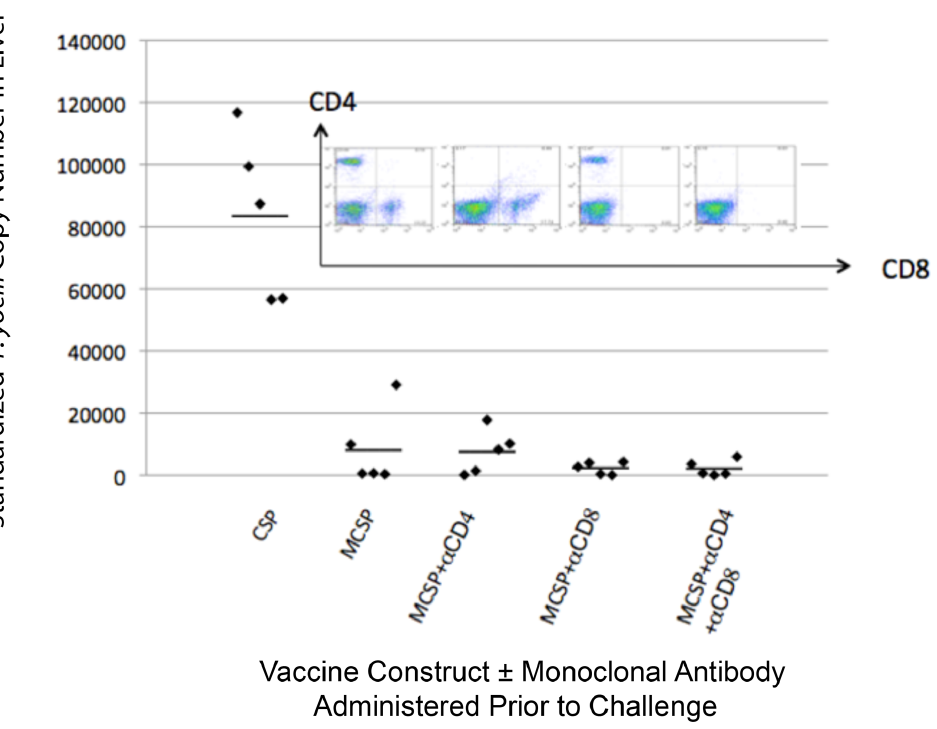
Figure 6. Effect of T cell depletion just prior to challenge on protection provided by Vaxfectin plus MCSP immunization. Two weeks after the final immunization, recipients of MCSP DNA were depleted of CD4, CD8 or both T cell subsets. The efficacy of the T-cell depletions is indicated by the flow cytometry analysis shown in the inset. The mice were then challenged with 2 6 10 3 P. yoelii sporozoites. The standardized P. yoelii rRNA copy number in the livers of individual mice (5/group) and the mean for each group are shown. Not shown in the figure is that all immunized mice received Vaxfectin in addition to the indicated DNA constructs. The MCSP plus Vaxfectin immunized groups did not differ significantly from each other independent of T cell depletion (p=1.000) and all MCSP + Vaxfectin immunized mice had significantly fewer rRNA copies than the CSP plus Vaxfectin immunized mice (p , 0.001).